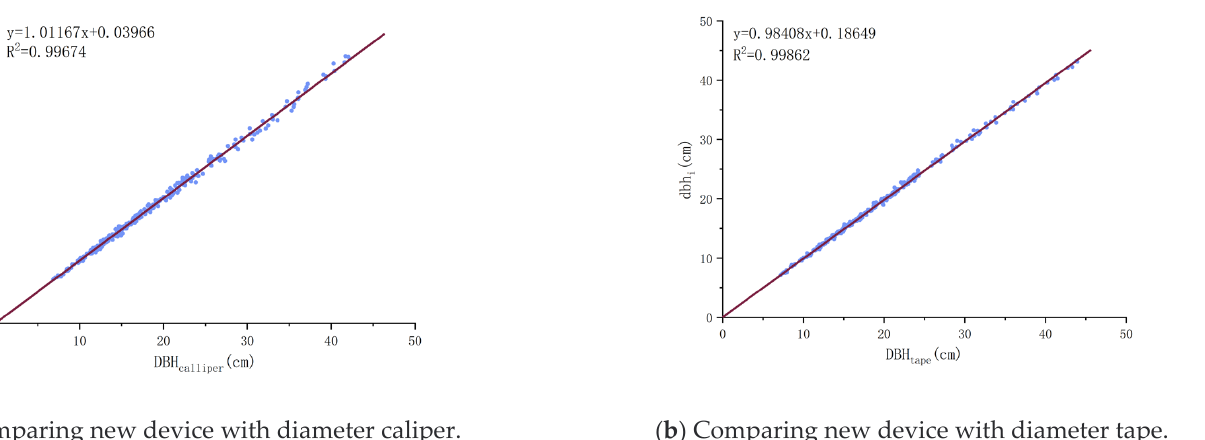
Figure 8. Linear fitting diagram of dbh i , DBH capliper, and DBH tape . Table 2. Comparison of DBH data of different tree species.